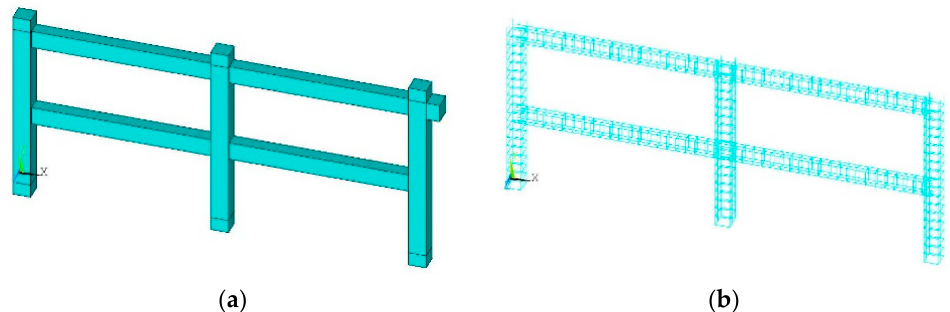
Figure 16. Model of the frame. ( a ) Geometrical model for the concrete. ( b ) Model for the steel framework.